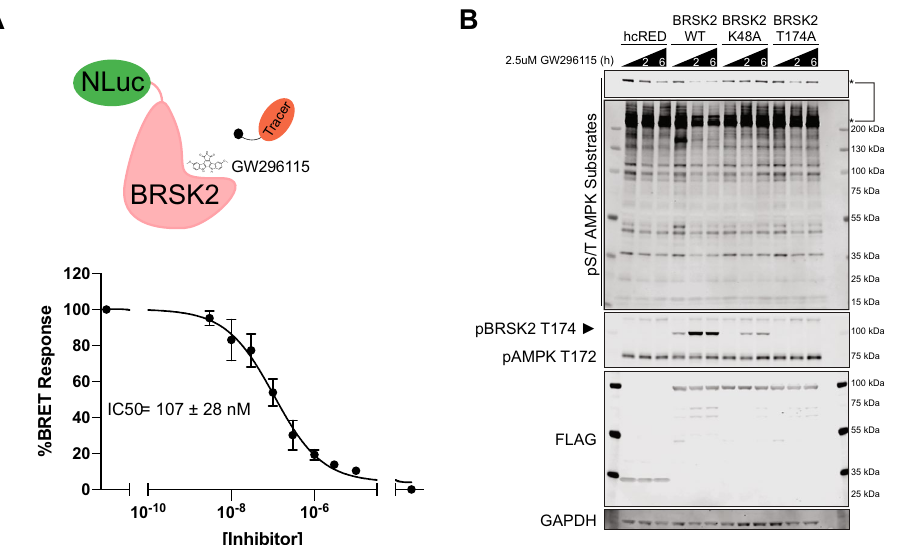
Figure 3. GW296115 inhibits BRSK2 in cell-based assays. ( A ) GW296115 engages BRSK2 in cells with an IC 50 = 107 ± 28 nM. HEK293 cells were transiently transfected with NLuc-BRSK2 and GW296115 target engagement was calculated by measuring the dose-dependent displacement of the tracer (N = 3). ( B ) GW296115 inhibits kinase active BRSK2 and downregulates AMPK substrate phosphorylation. HEK293T cells transiently expressing hcRED, wild type (WT), or kinase dead (K48A & T174A) were treated with 2.5 μM of GW296115 for 2 or 6 h. Unformatted images of blots are included in Fig.